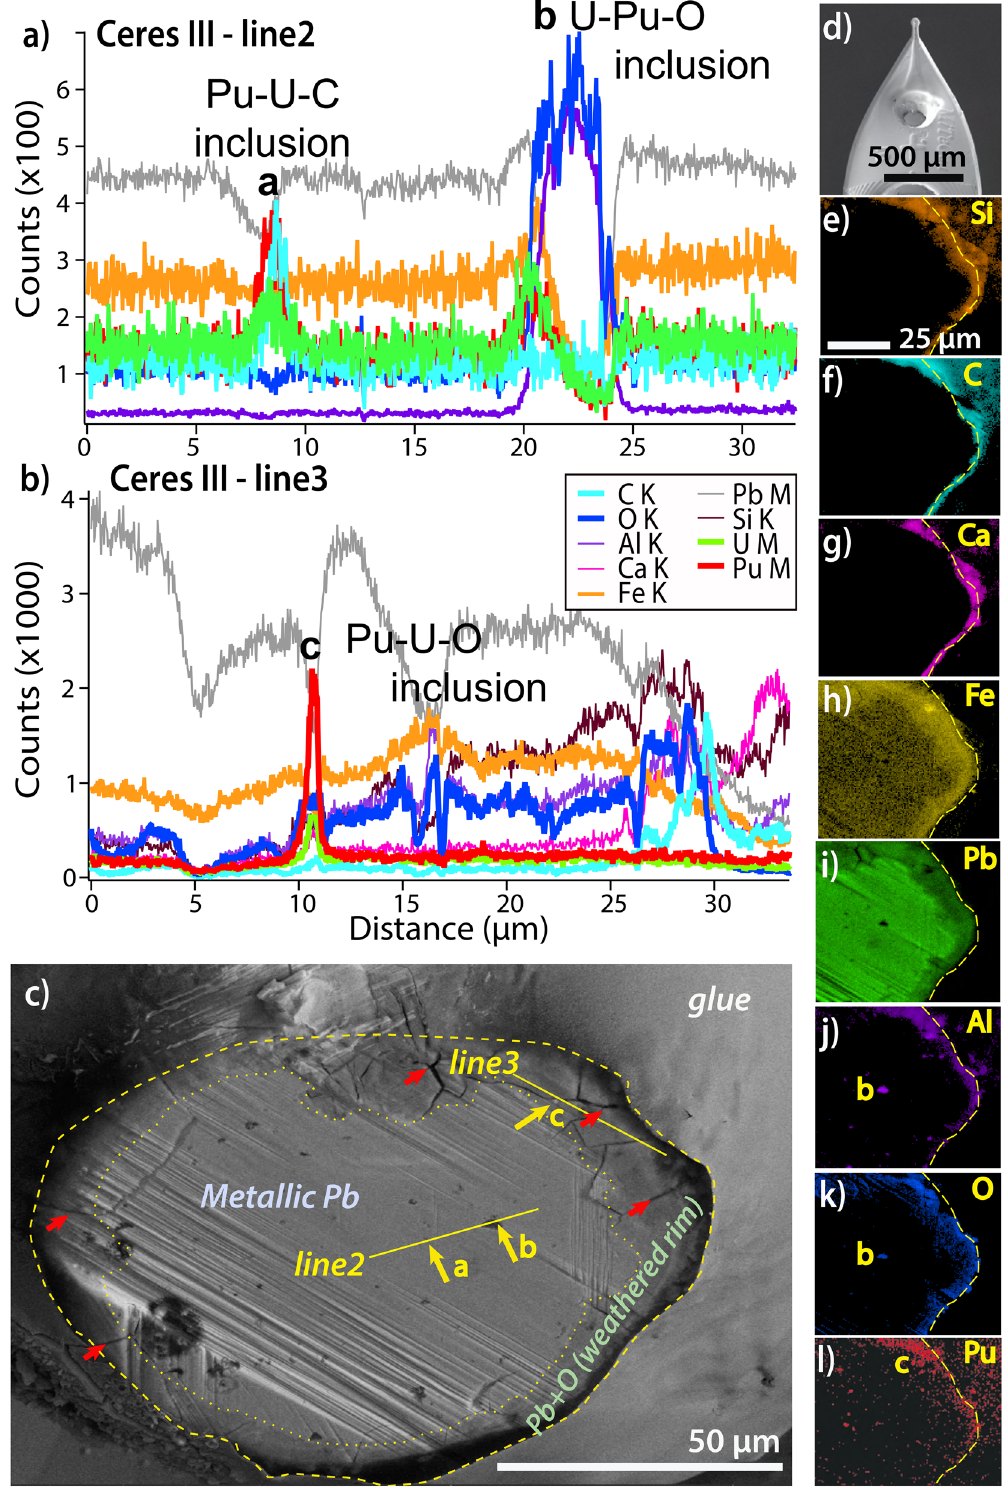
Figure 5. FIB-SEM EDX characterization of CeresIII . ( a , b ) FIB-SEM EDX line scans of selected areas within CeresIII . ( c ) SEM image of FIB cross-section of the particle. ( d ) Overview of the particle mounted on kapton micromount. ( e – l ) Represent false colour EDS element maps for each respective element. This particle is predominantly metallic Pb, with some Fe and traces of Pu–U in the center; there are also a couple of Pu–U–C particles (at sites labelled ‘a’ and ‘b’, line 2). There is a rim of Pb–O, which contains a particle comprised of Pu–U–O (arrow and site ‘c’, line 3) and an outer rim containing Ca–C–O (most likely calcite, CaCO 3 ) and Si (most likely a silica polymorph). Imaging and EDS analyses performed at 20 keV acceleration